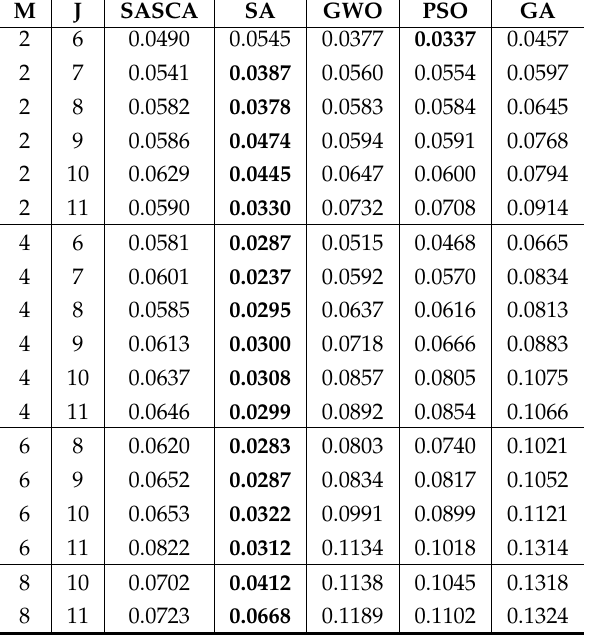
Table 3. Average of the computational time of the small problems for each algorithm (best results are in